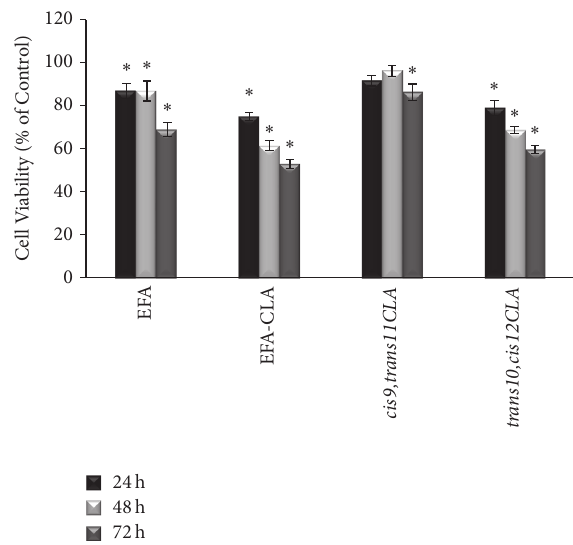
Figure 1: Effect of fatty acids on MCF-7 cells viability. Values are expressed as means ± SD for 𝑁 ≥ 9 , standardized to control (NC) as 100%. Statistical significance was based on 𝑡 -test; ∗ 𝑝 < 0.05 versus